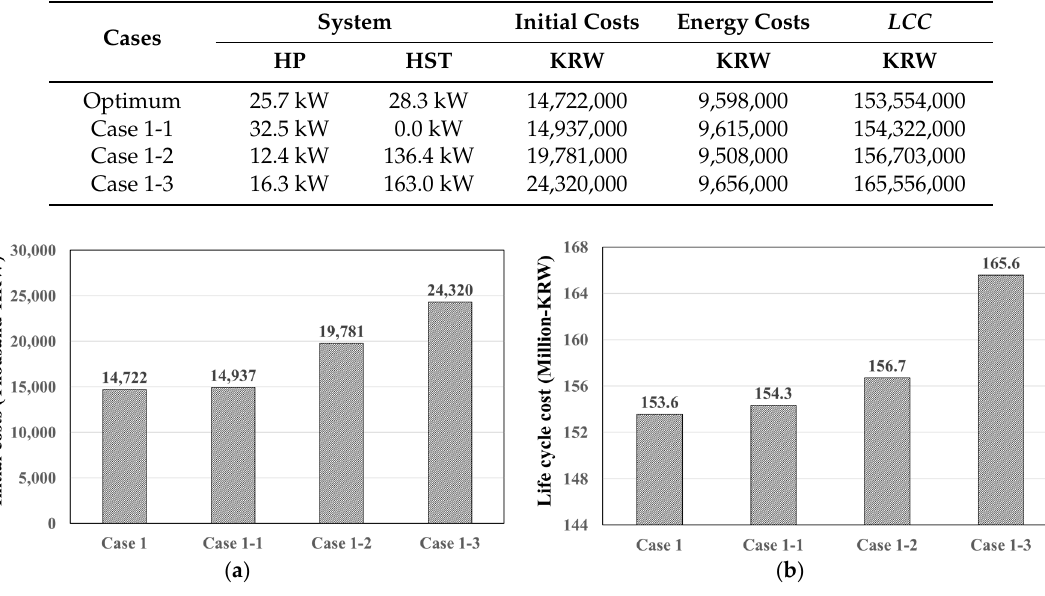
Figure 13. Comparison of the initial cost and LCC in cases. ( a ) Initial costs in cases; ( b ) Life cycle cost in cases.